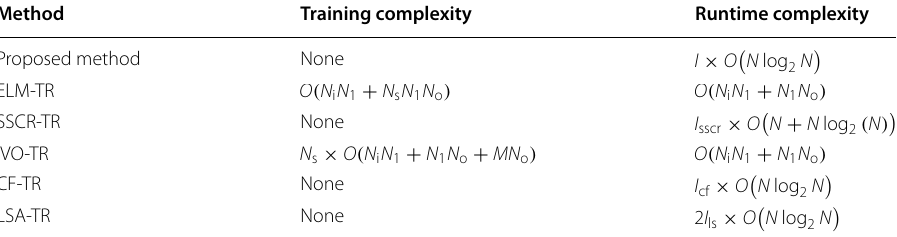
Table 3 Simulation parameters Total subcarriers, N 64 Subcarrier modulation Number of OFDM